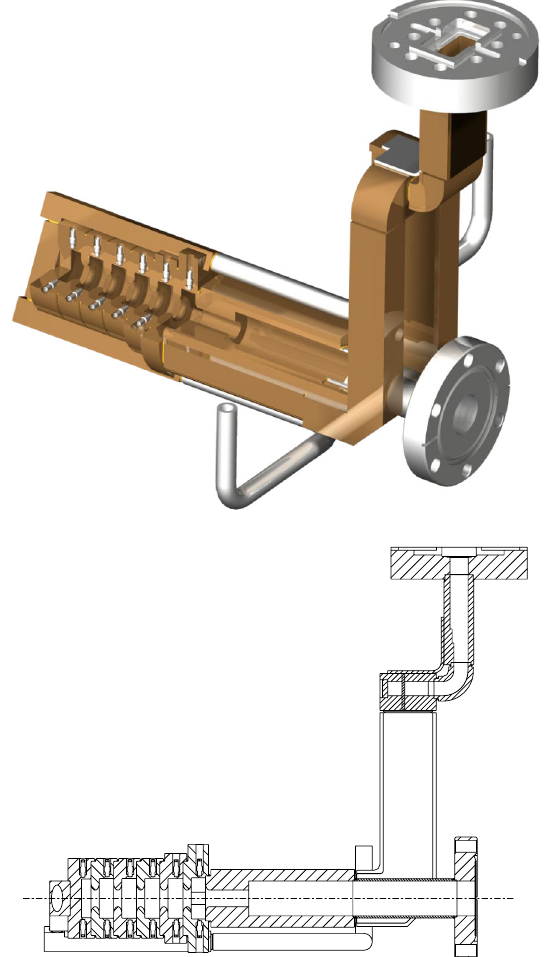
FIG. 1. CAD rendering and schematic of the Mark 1 X -band rf gun.